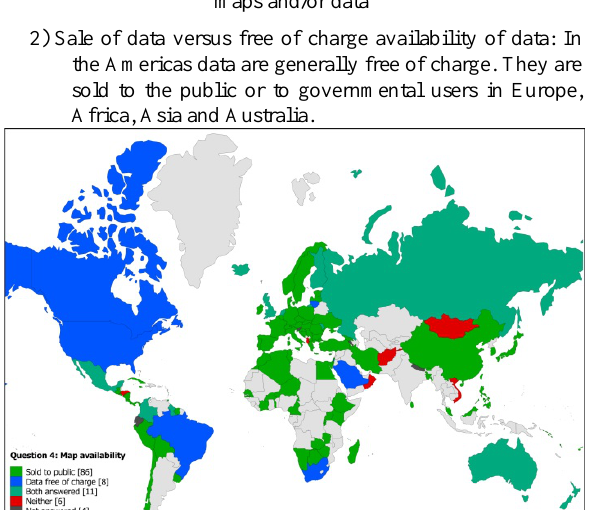
Figure 6: Question 3. Restricted access or limited circulation to